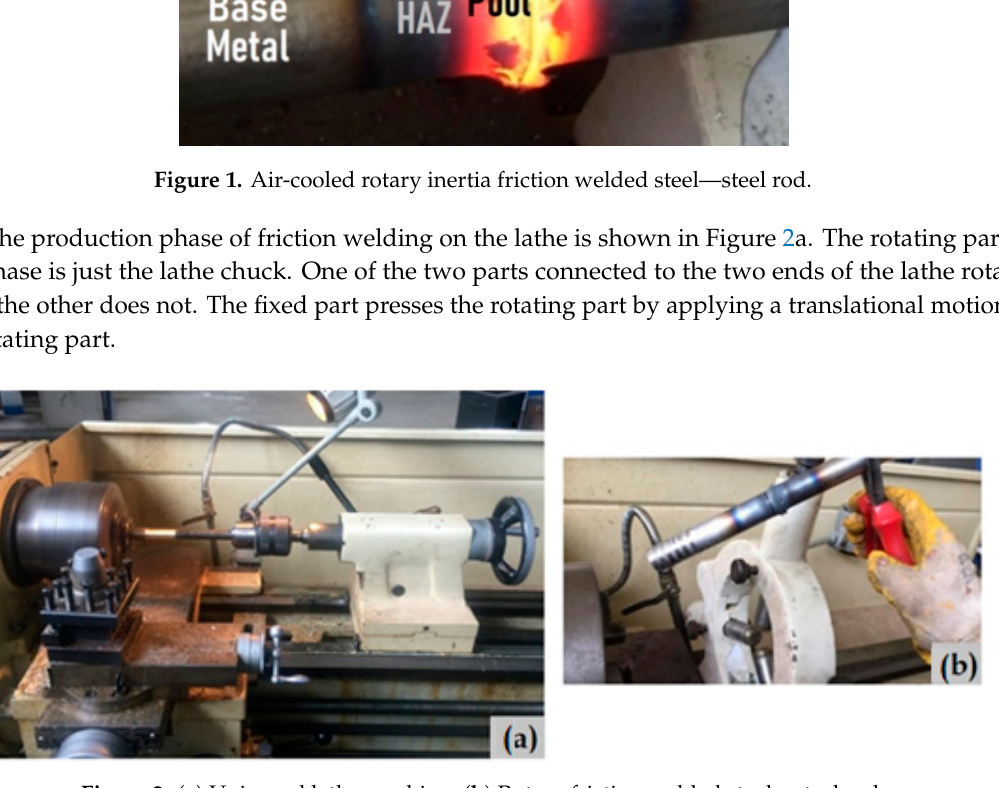
Figure 2. ( a ) Universal lathe machine. ( b ) Rotary friction welded steel—steel rod.